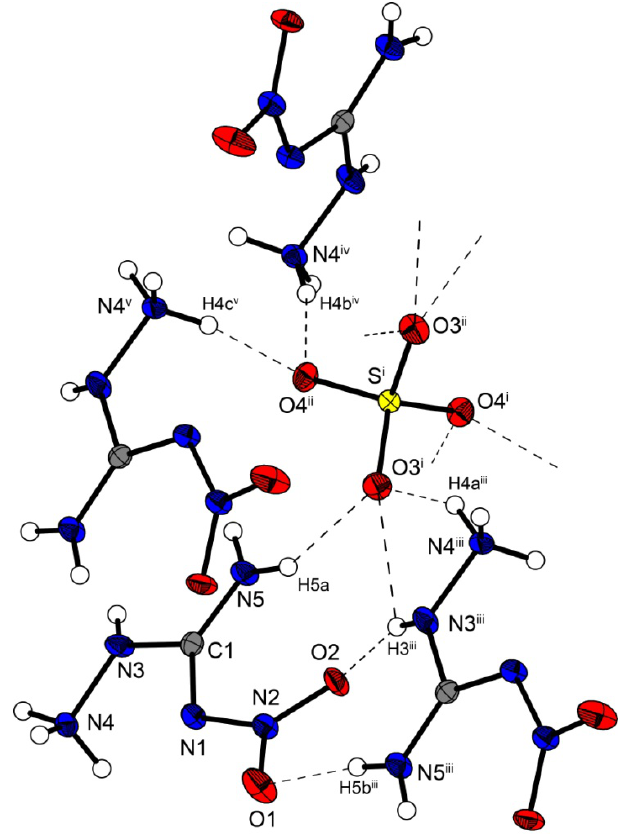
Figure 7. Molecular structure of bis(amino-nitro-guanidinium) sulfate ( 5 ). Ellipsoids are drawn at the 50% probability level. Symmetry codes: (i) 0.75 − x , 0.25 + y , 0.75 + z ; (ii) − 0.25 + x , 0.25 − y , 0.75 + z ; (iii) 0.25 + x , 0.25 − y , − 0.75 + z ; (iv) 0.25 − x , 0.25 + y